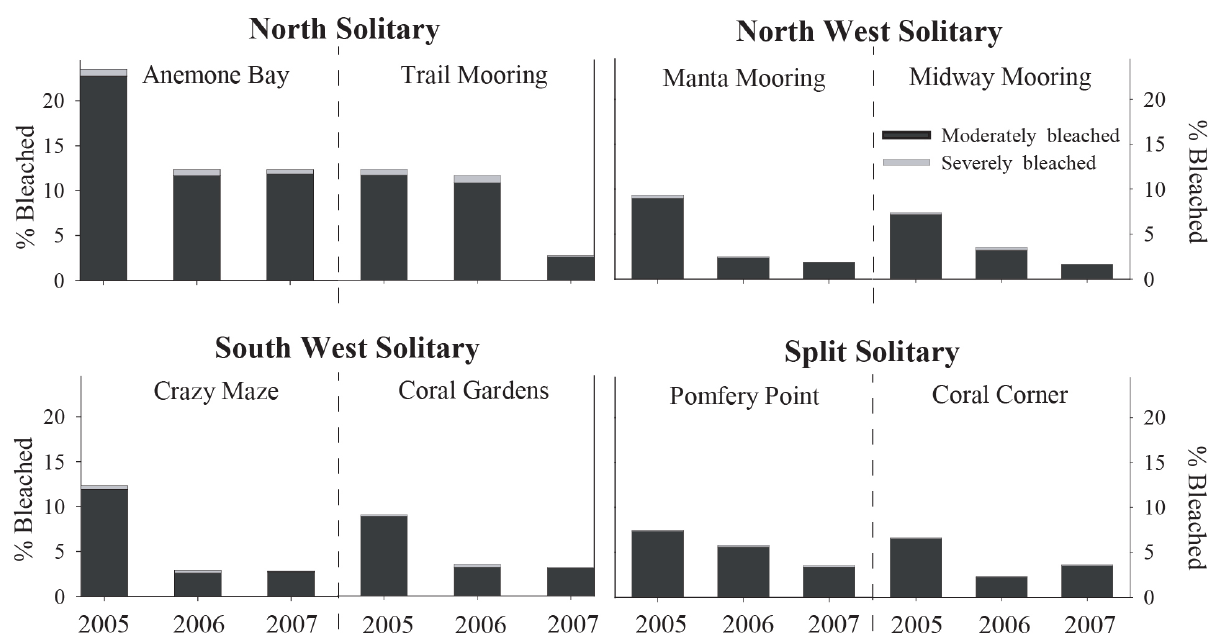
Figure 2. Average proportion (n = 5 belt transects per site) of moderate (dark grey) and severe (light grey) coral bleaching categories recorded at eight island reefs within the SIMP, surveyed in summer